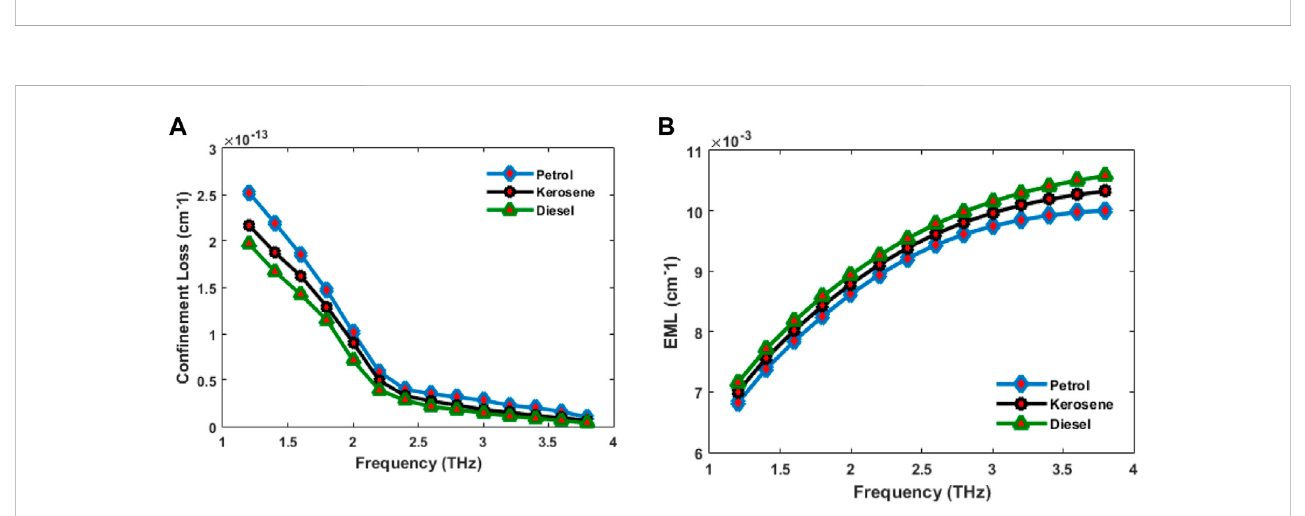
FIGURE 6 (A) Con fi nement loss vs. operating frequency, (B) EML vs. operating